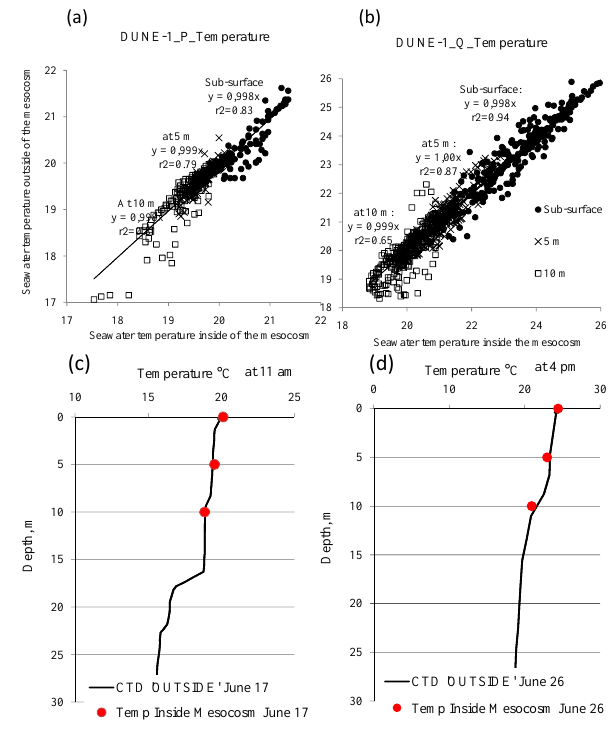
Fig. 15. Comparison of the temperatures ( ◦ C) measured continu- ously (1 data/h) inside and outside one of the six mesocosms at three fixed depths during the DUNE1-P experiment (a) and the DUNE1- Q experiment (b) . In addition, a comparison between the temper- ature inside the bags at 0.1, 5 and 10m along with the tempera- ture data acquired by CTD at the same time in open waters at the “OUTSIDE” site (c) on 17 June at 11:00a.m. and (d) on 26 June at